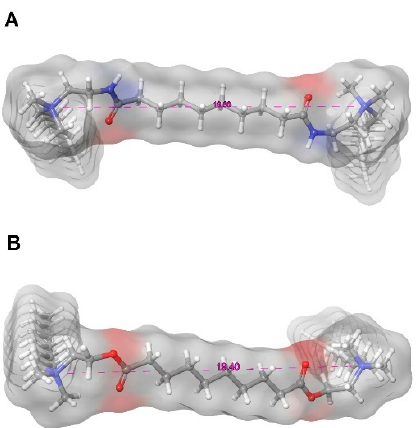
Figure 6. Particle size spectra obtained from the time correlation functions using the CONTIN algorithm for a8 and e8 gemini surfactants.